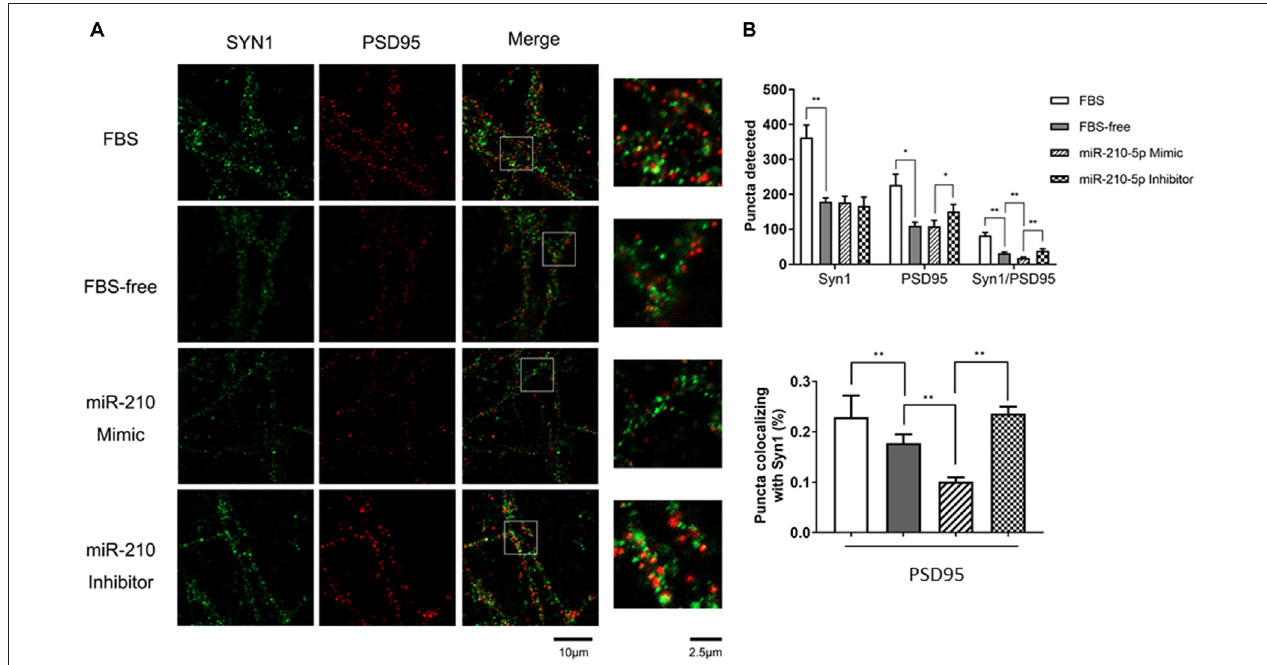
FIGURE 3 | miR-210-5p downregulates postsynaptic density. ( n = 3/group, 2 images per sample). (A) Green puncta were stained using Synapsin1 (Syn1) antibody, which represents pre-synapses. Red puncta stained with PSD-95 means post-synapses. The puncta colocalized with Syn1 and PSD-95 indicates functional synapses. (B) Quantification results of puncta in each channel; the colocalized synaptic density is normalized by pre-synapses respectively. Data are shown as mean ± SD values, and statistical significance between both groups is defined as ∗ p < 0.05; ∗∗ p <